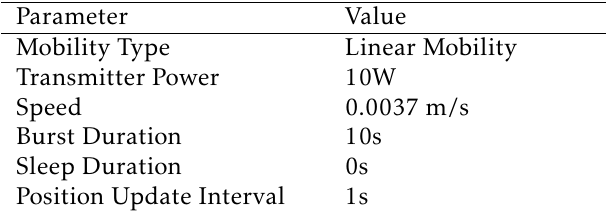
Figure 7. Satellite ground track [34]